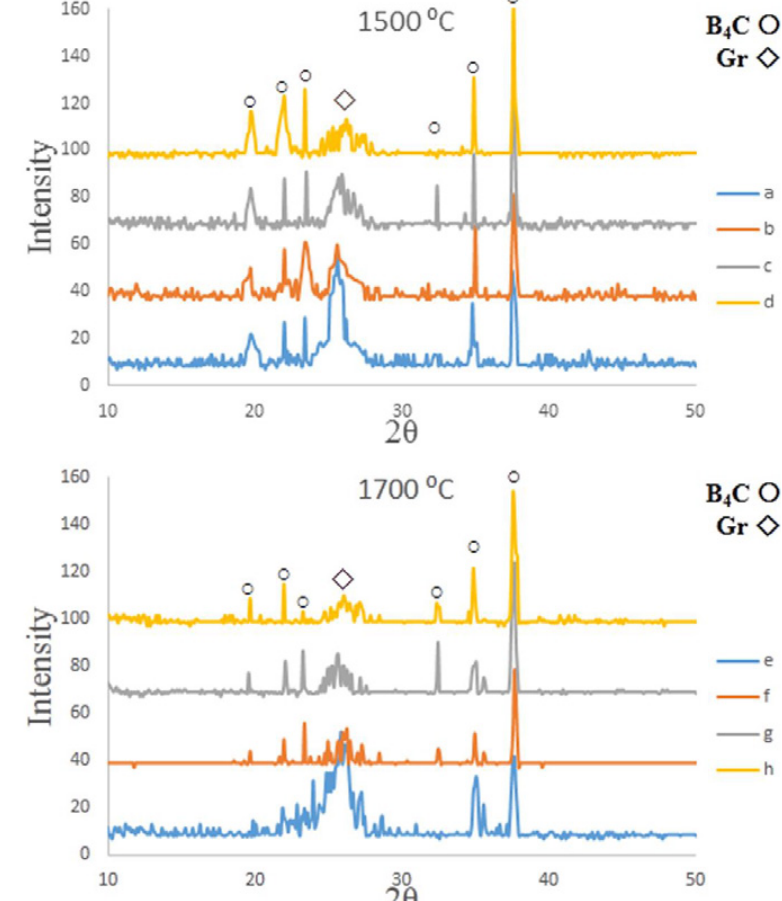
Fig. 4. The XRD patterns of the B